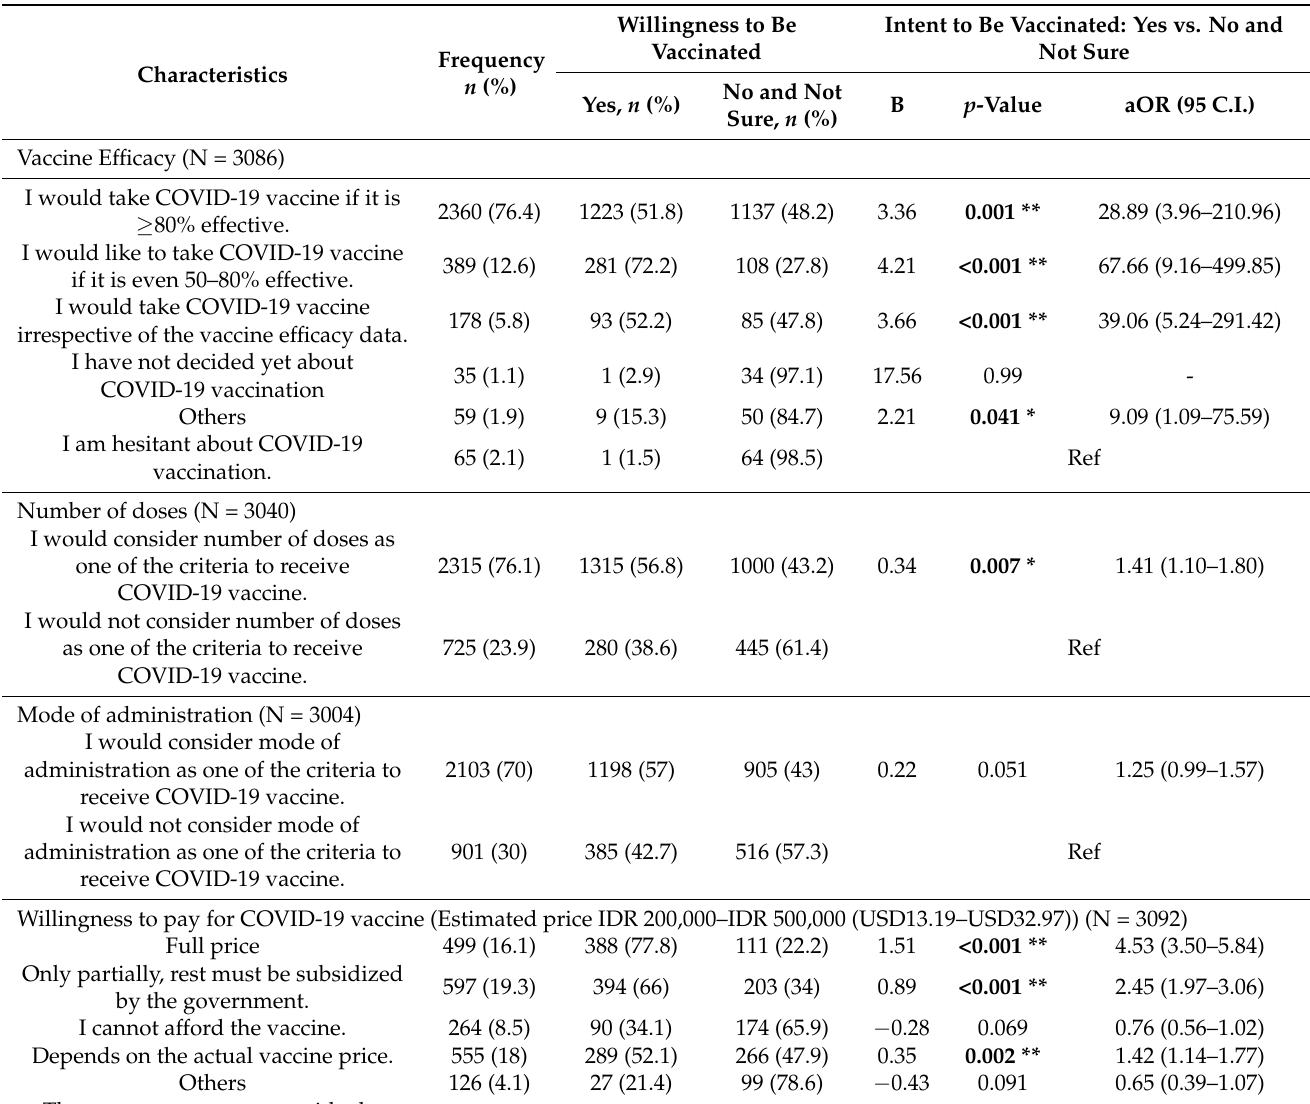
Table 4. Multivariate regression analysis of vaccine efficacy, number of doses, mode of administration and willingness to pay as predictors of receiving the